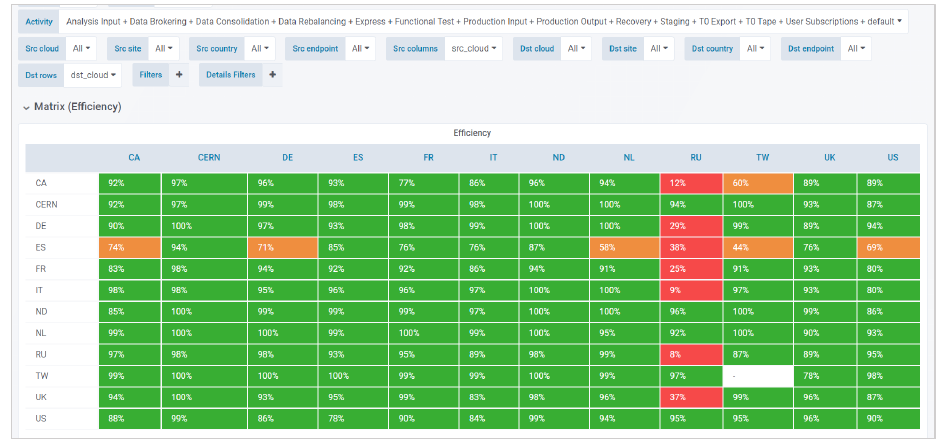
Fig. 5. Dashboard of the WLCG Transfers of each Experiment